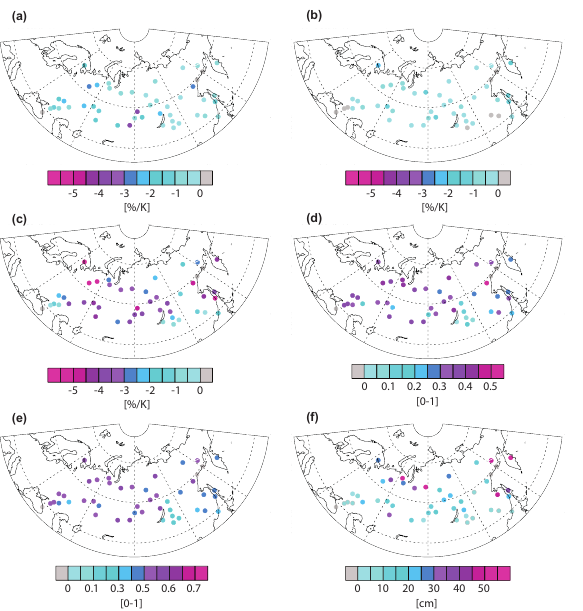
Figure 3. Mean SAF components in station data for 2000–2013 MAMJ: (a) SNC, (b) TEM, (c) snowmelt sensitivity, (d) mean albedo contrast, (e) mean albedo, (f) snow depth.